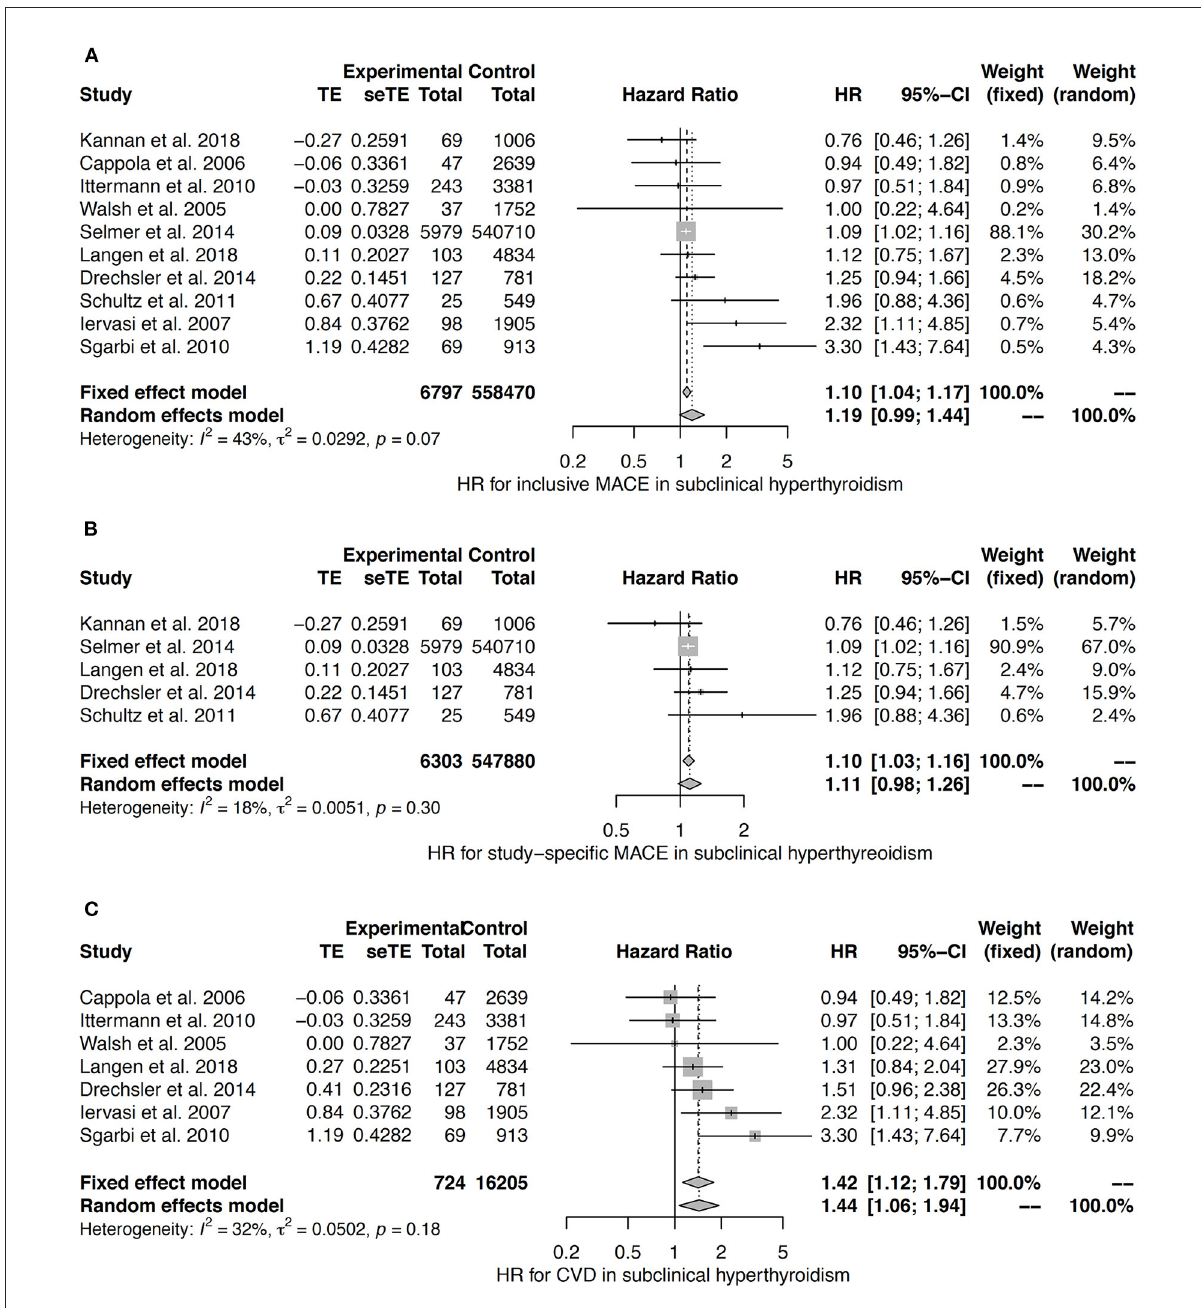
FIGURE9 HR for MACE (A,B) and CVD (C) in subclinical hyperthyroidism (42, 121, 123, 126, 140,